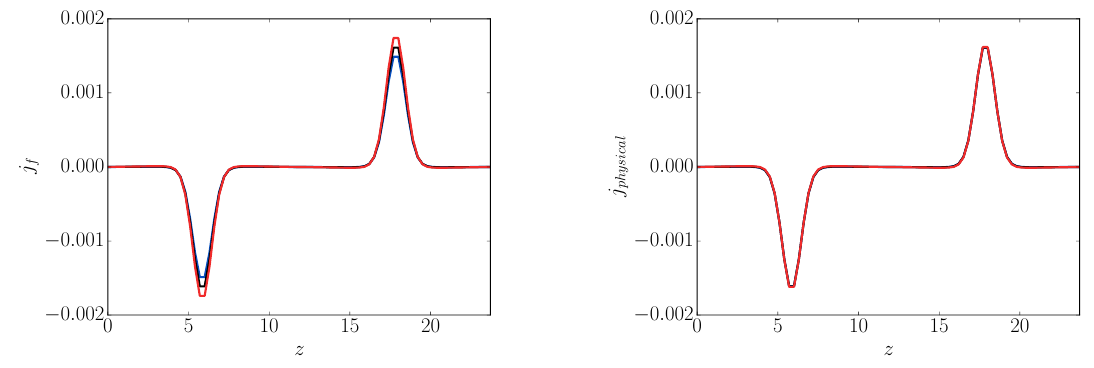
Figure 6 . The bare current j f (left) and the renormalized current (right) for (cid:1) x 1 = 0 : 4 (blue), 0.3 (black), 0.2 (red). (cid:11) = 0 for (cid:1) x 1 = 0 : 2 and (cid:11) = 0 for (cid:1) x 1 = 0 : 2; (cid:1) x 2 = 0 : 3 is the reference lattice spacing where (cid:11) 0. N x (cid:1) x 1 = N y (cid:1) x y = 9 : 6, N z (cid:1) x 3 = 9 : 6, q = 0 : 3, e = 1 and periodic (cid:17) boundaries are applied in all